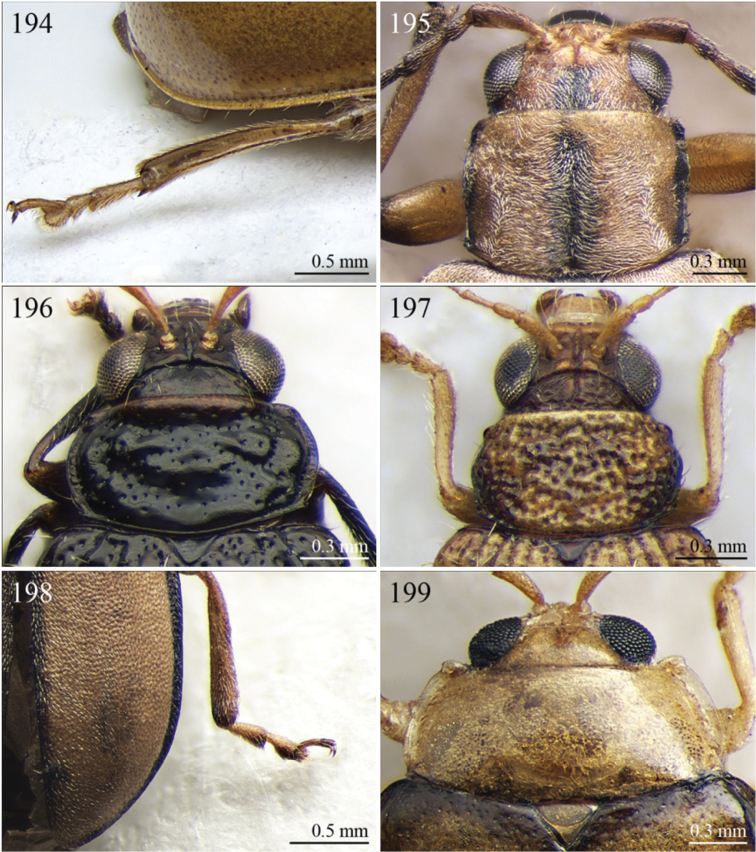
Morphological characters. 194
Hemipyxis obscuretestaceum (Thomson), hind tibia and metatarsus 195
Hespera maculicollis Jacoby, head and pronotum in dorsal view 196
Hildebrandtina obscura Bechyné, head and pronotum in dorsal view 197
Hildebrandtina similis Bechyné, head and pronotum in dorsal view 198
Homichloda barkeri (Jacoby), hind tibia and metatarsus and elytral surface 199 Hyphasis sita (Maulik), head and pronotum in dorsal view.